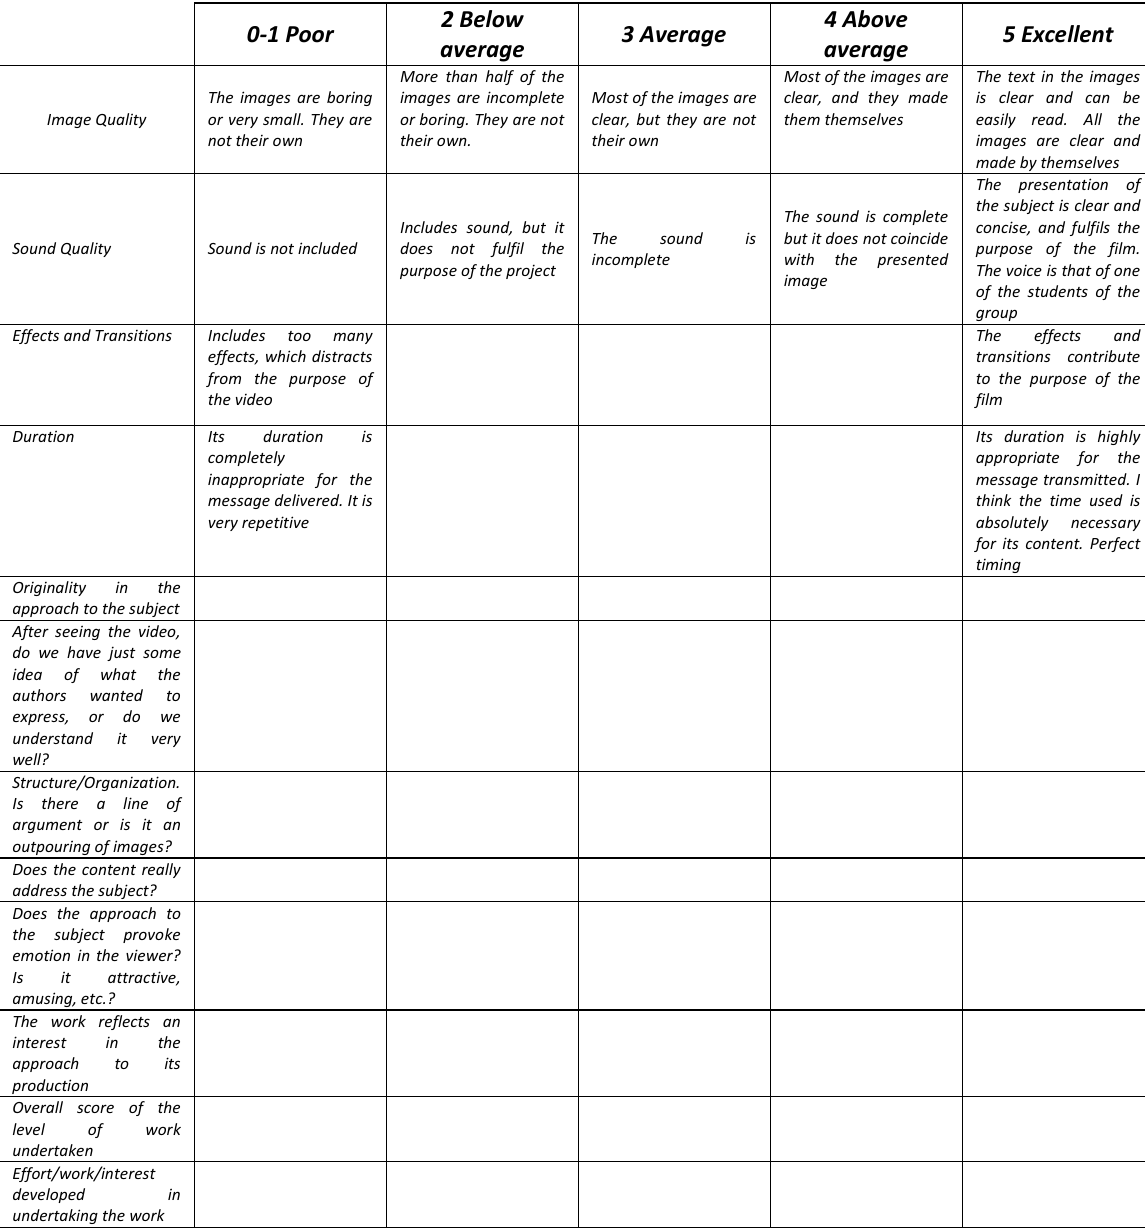
Table 1. Assessment tool used to assess the presented